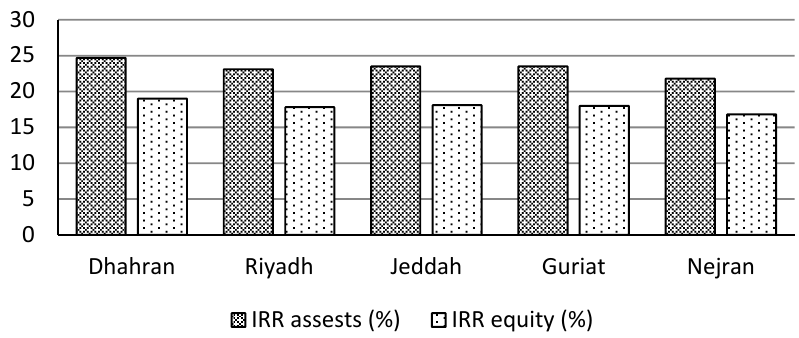
Figure 15. IRR assets and equity for all sites.